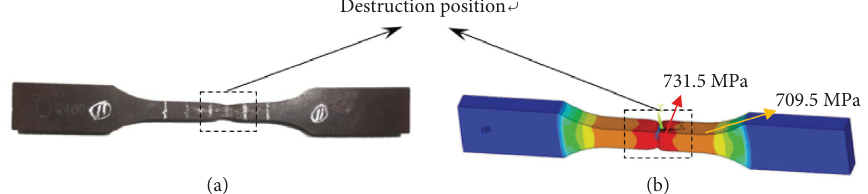
Figure 13: Results comparison of specimen L-A-3. (a) Failure pattern in the experimental test. (b) Failure pattern in finite element simulation.